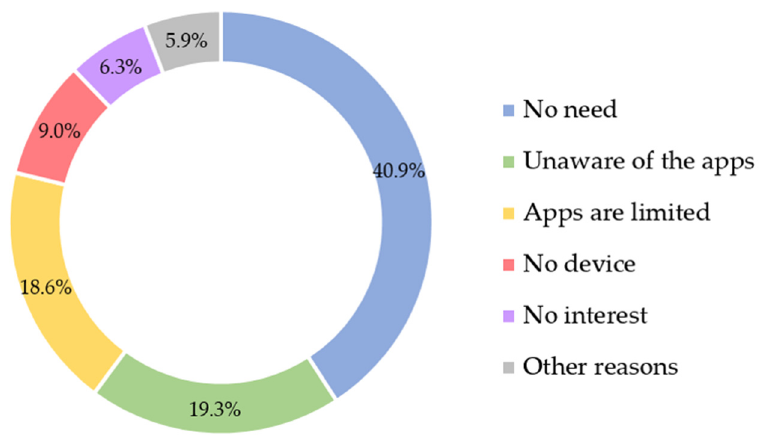
Figure 6. Barriers preventing the use of pedestrian navigation apps.